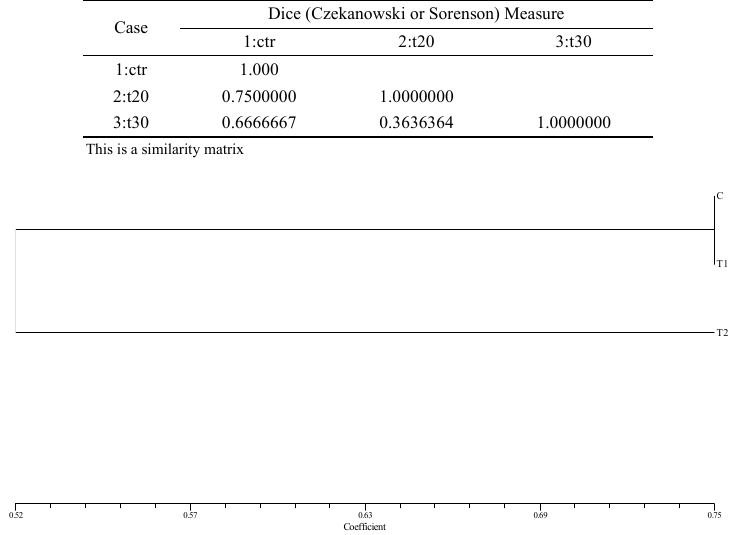
Table 11: Similarity matrix for nisin, CuO, and CuO NPs conjugated with nisin at the same concentration of 30μg/mL